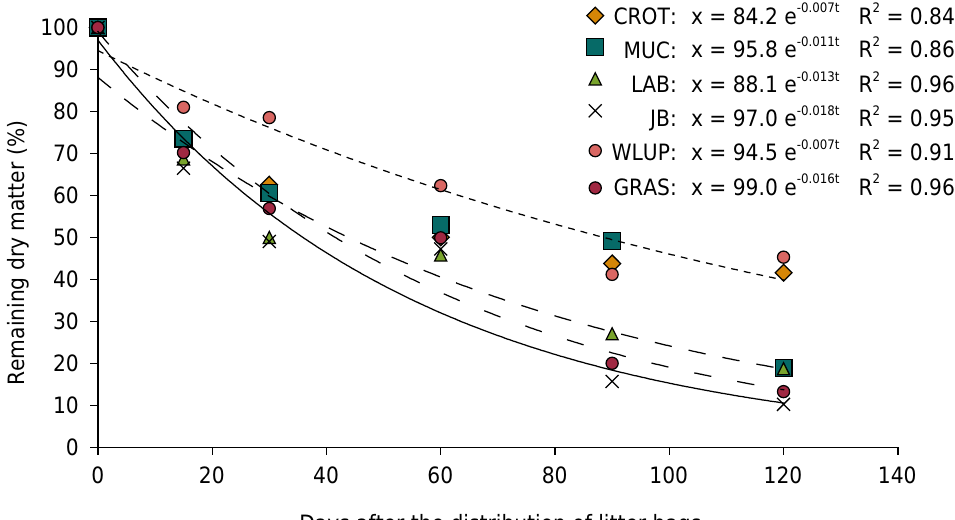
Figure 4. Dry matter remaining in litter bags filled with different litter from cover crops incubated for 120 days on the soil surface. Values represent means of three replicates. Curves fitted in the exponential model: x = x 0 e -kt . CROT: Crotalaria juncea (sunn hemp); MUC: Mucuna aterrima (velvet bean); LAB: Dolichos lablab (lablab bean); JB: Canavalia ensiformis (Jack bean); WLUP: Lupinus albus (white lupine); GRAS: Urochloa maxima (Guinea